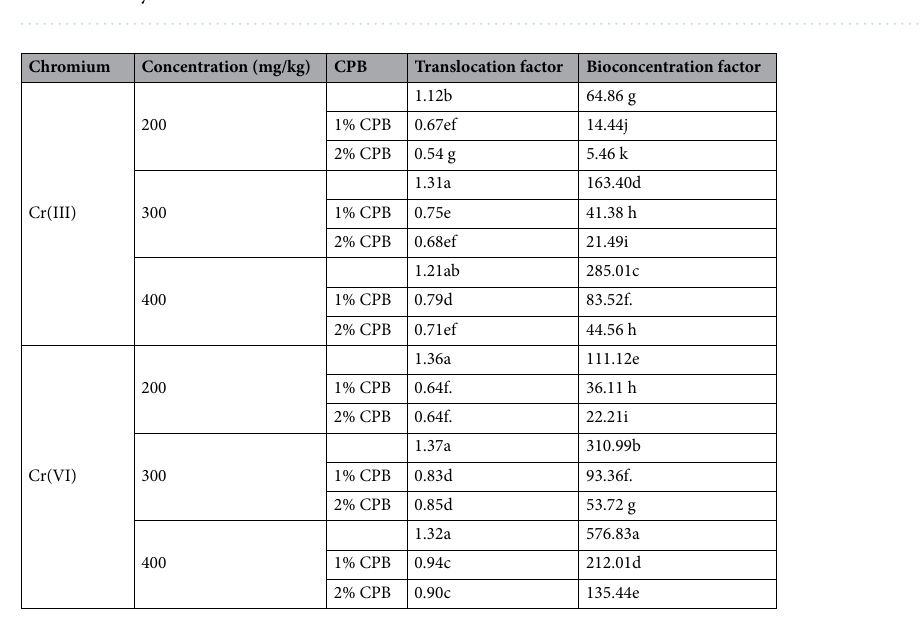
Figure 6. ( a and b ) Metal uptake by different parts of tomato plant due to soil amendment with plant biomass of Cloncurry buffel grass (CPB) under Cr(III) (a) and Cr(VI) (b) stress. Vertical bars show standard errors of the means of three replicates. Values with different letters at their top show a significant difference (p ≤ 0.05) as determined by the LSD test.